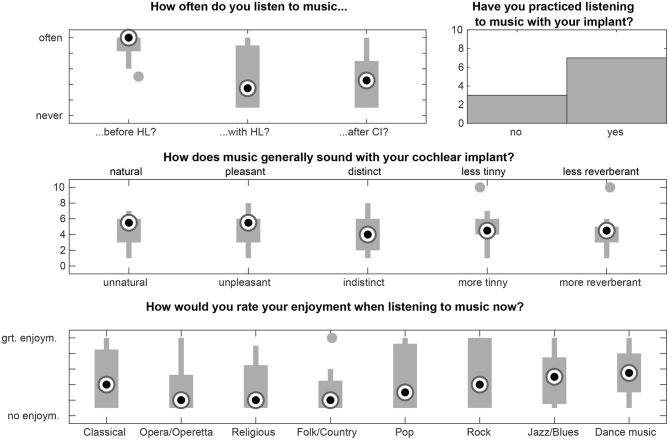
Results from the Munich Music Questionnaire for the selected items “How often did you listen to music before your hearing loss/with your hearing loss prior to receiving your cochlear implant (CI)/now, after receiving your CI?”, “How does music generally sound with your cochlear implant?”, “How would you rate your enjoyment when listening to music now?” and “Have you practiced listening to music with your implant?” The participants filled out a German version of the questionnaire. The items and labels used here are taken from the English questionnaire. Filled circles denote outliers.